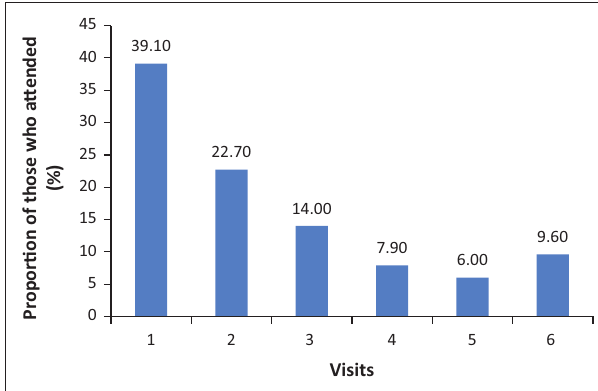
FIGURE 1: Pattern of attendance of scheduled ototoxicity monitoring